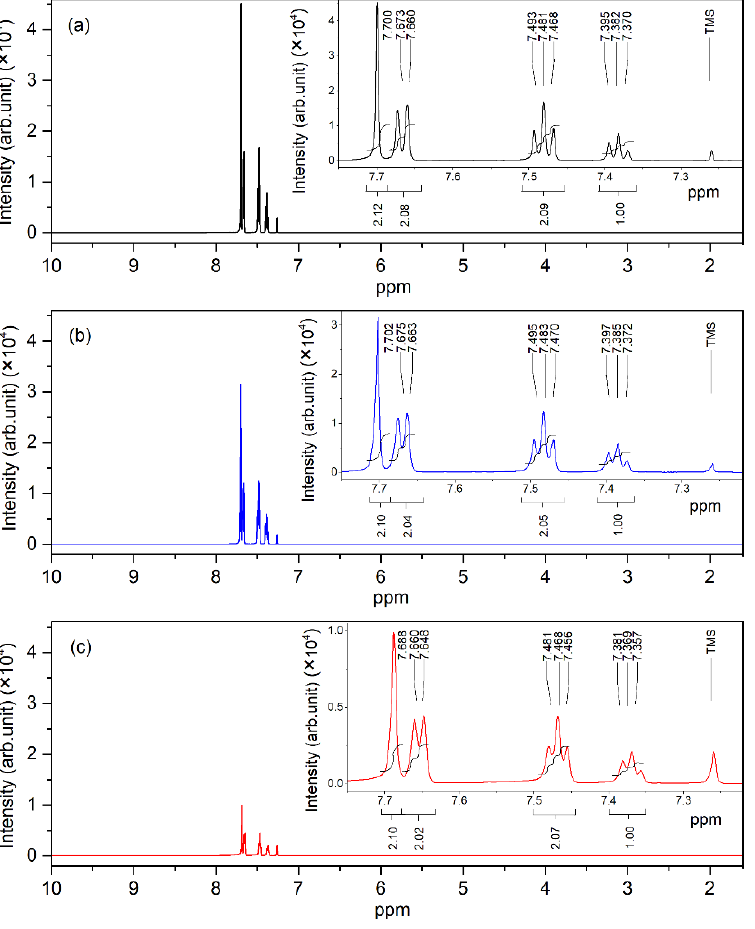
Figure 9. 1 H NMR spectra of ( a ) pure, ( b ) 0.01 wt.%, and ( c ) 0.1 wt.% pentacene-doped p-terphenyl crystals.